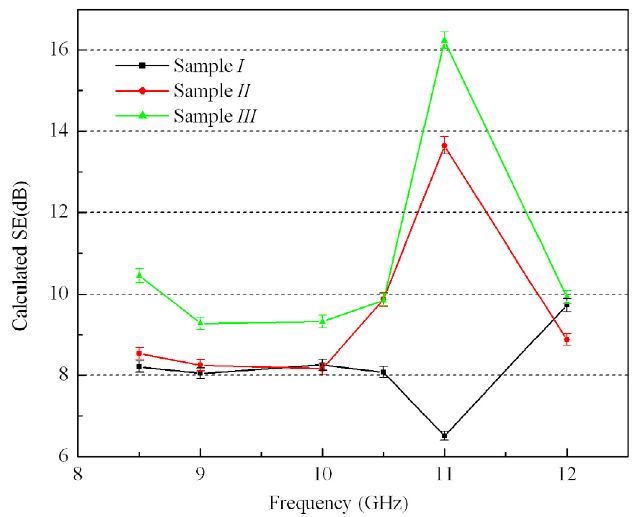
Fig. 4. The SE values of textiles along with the expanded